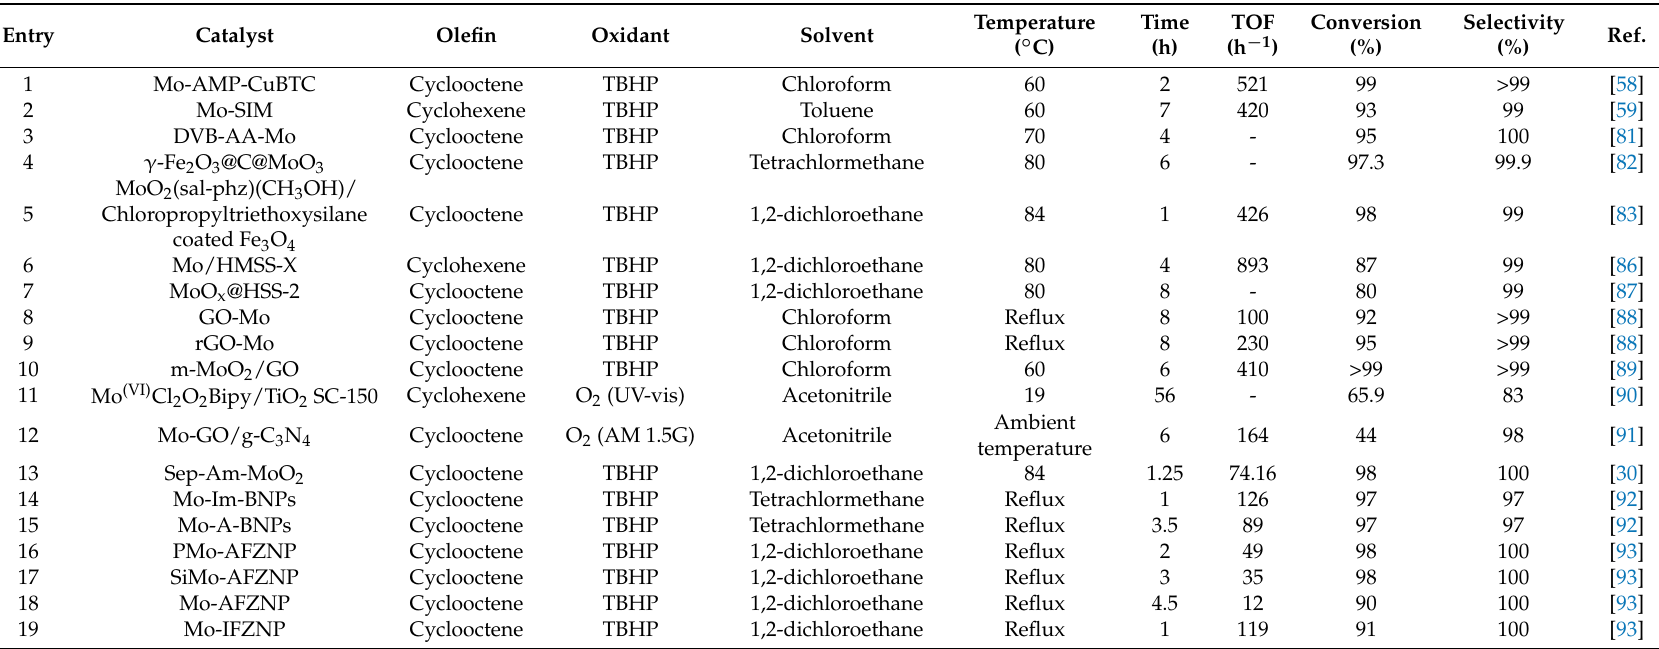
Table 4. Results of epoxidation by using different types of heterogeneous molybdenum-based